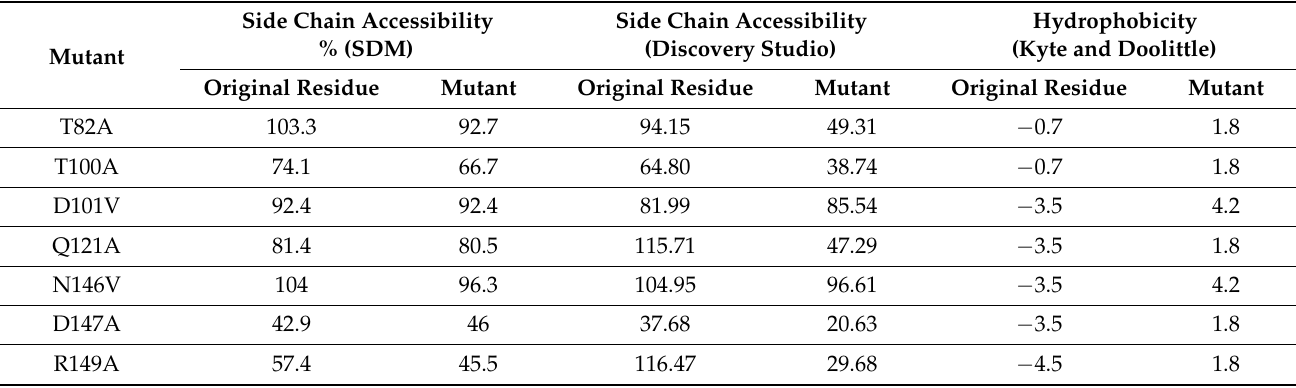
Table 3. Accessibility and hydrophobicity of residues before and after mutation. The R149A mutant revealed the most decrease in Side chain accessibility in both SDM and Discovery studio. By exploiting mutation to short side chain and non-polar amino acids, it is clear that hydrophobicity of all mutants has been increased, which could bring about a reduction in